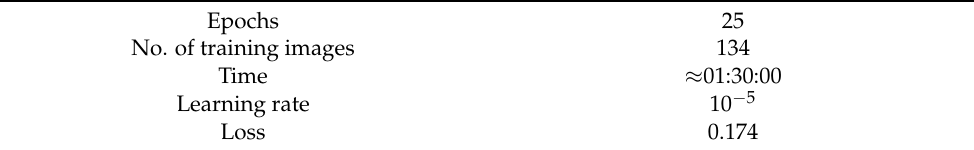
Table 1. Basic model training parameters and